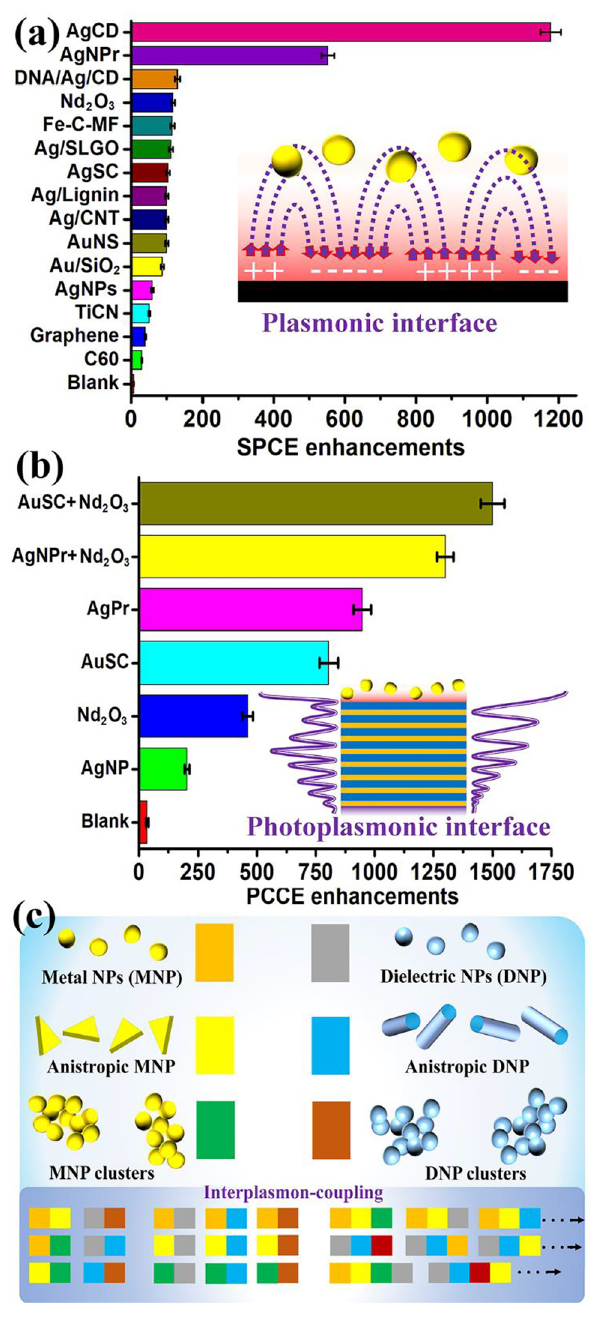
Figure 6: (a) SPCE enhancements obtained with variety of NPs, nanohybrids and composites. The inset shows plasmonic coupling between metal NPs of interest and SPCE substrate. (b) PCCE enhancements obtained with different nanomaterials from our laboratory. >1500-fold experimental PCCE enhancements demon- strated in this work with the use of AuSC (metal) + Nd 2 O 3 (dielectric) synergy on 1DPhC nanocavity interface is the maximum that is re- ported so far. On account of judicious utility of both plasmonic and dielectric frameworks, we have termed this as photoplasmonic interface. (c) A snapshot of the futuristic scope of the photo- plasmonic nanointerface indicating different opportunities